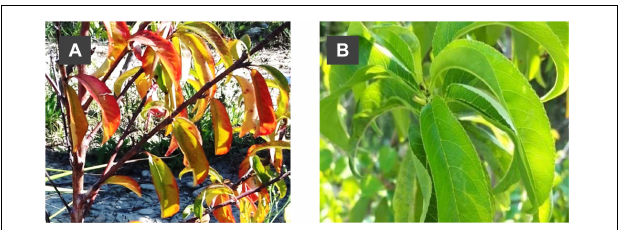
FIGURE 1 | Visual diagnosis of both graft-combinations at the third year after grafting: (A) External symptoms of “translocated” incompatibility (curling, reddening and yellowing of leaves) in “SG/Damas GF 1869” graft-combination; (B) absence of graft-incompatibility symptoms in “SG/Adara” graft-combination (healthy leaves).